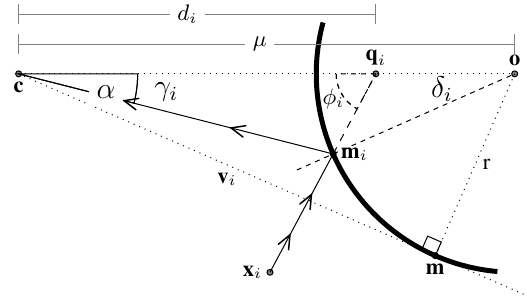
Figure 1. Geometry of the image formation using catadioptric spherical camera, with focus on the plane of reflection The parameters we model in this setup, include: the camera pro- jection center c (Fig. 1) and the spherical mirror center, o . The objective is to estimate these parameters using a set of reference- points, x i , which are projected onto the image plane from the sphere